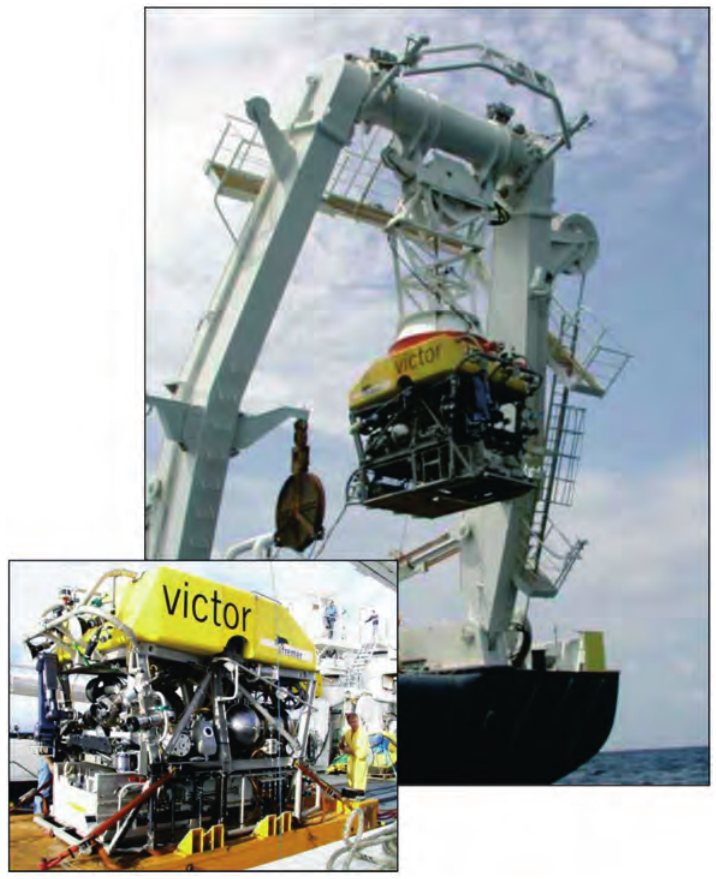
Fig. 2. The French deep-rated ROV Victor 6000 built and managed by IFREMER (see also table II). A detailed view of the ROV is shown in the bottom-left